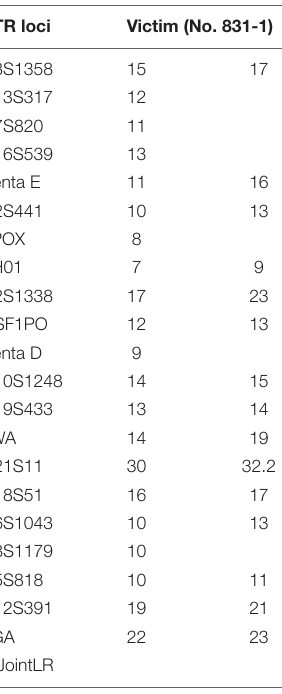
TABLE 8 | Average and combined LR for this